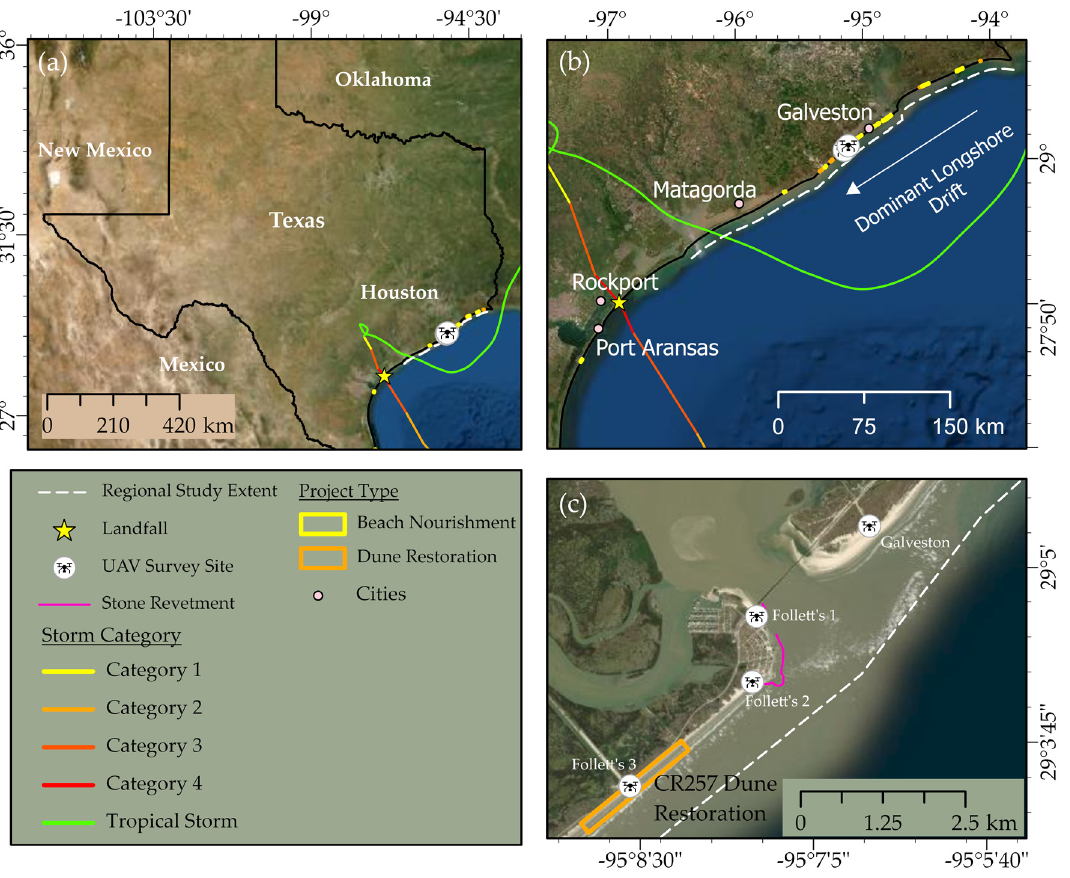
Figure 1. Study area. ( a ) Hurricane Harvey’s path and landfall in Texas; ( b ) Harvey path and landfall in relation to unmanned aerial vehicle (UAV) survey sites around San Luis Pass; ( c ) San Luis Pass with selected sites for UAV surveys showing Follett’s Site 3 within CR257 dune restoration boundaries (J. Paine, personal communication, 17 April 2021) and the stone revetment relevant to the “Treasure Island MUD Shoreline Protection” project.